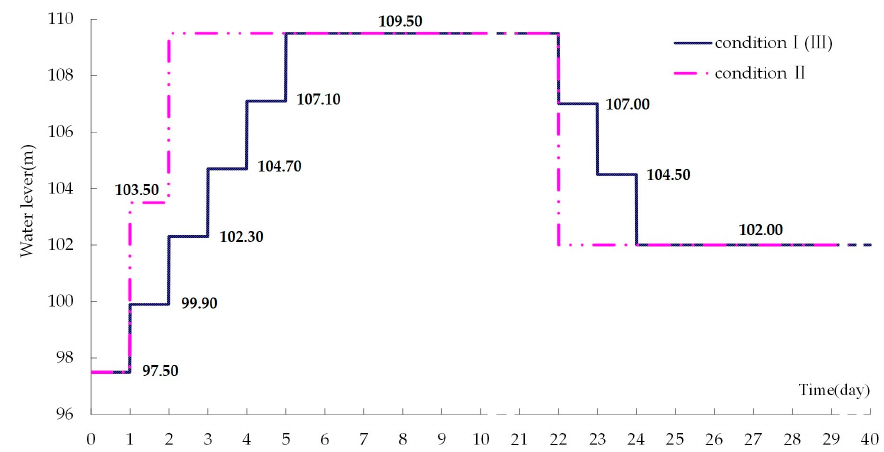
Figure 12. Reservoir water level time series analyzed with FEM.